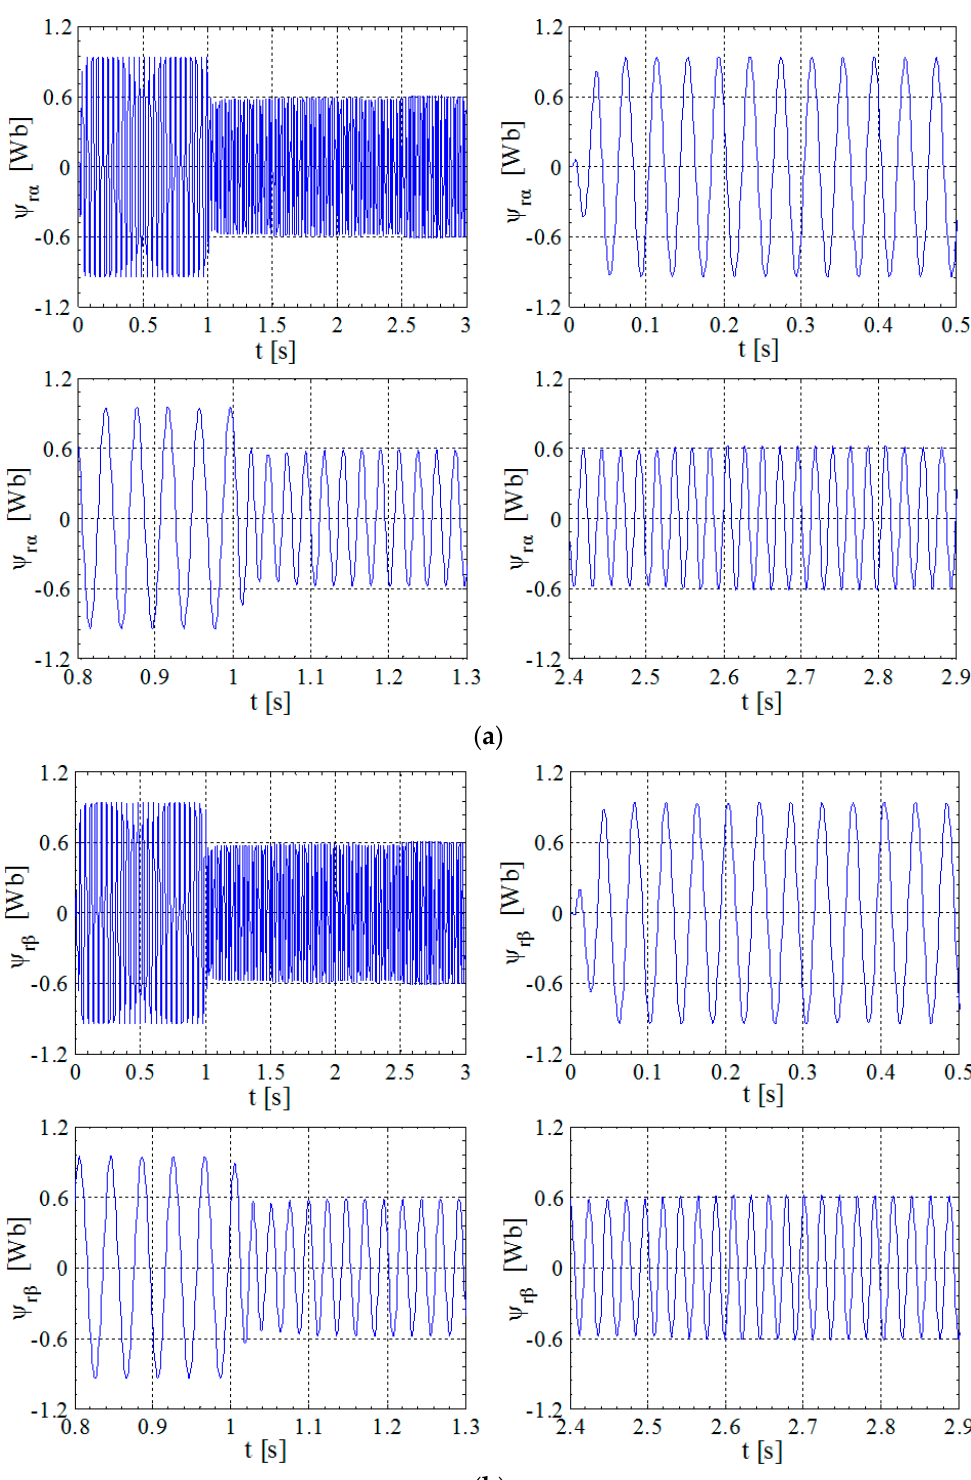
Figure 6. Response of rotor flux linkage: ( a ) α -axis rotor flux-linkage; ( b ) β -axis rotor flux-linkage.